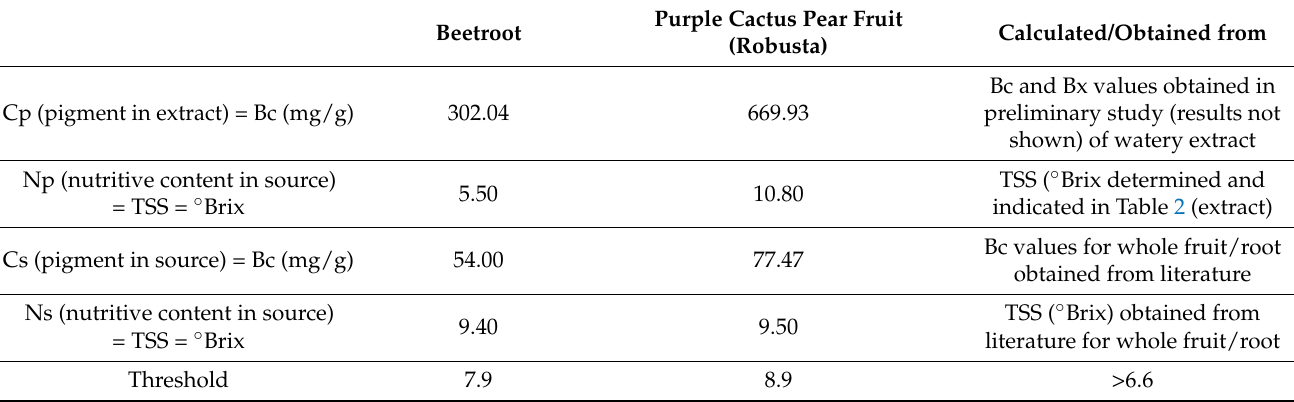
Table 4. Colouring food classification for beetroot and purple cactus pear cultivar. Purple Cactus Pear Fruit Beetroot